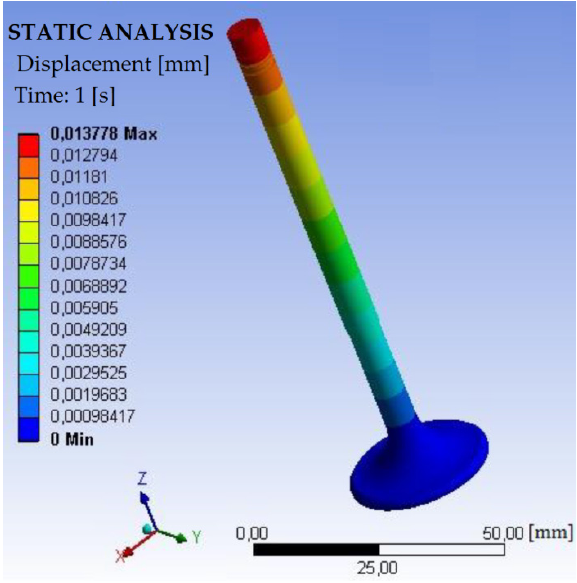
Figure 5. Static valve strain analysis.